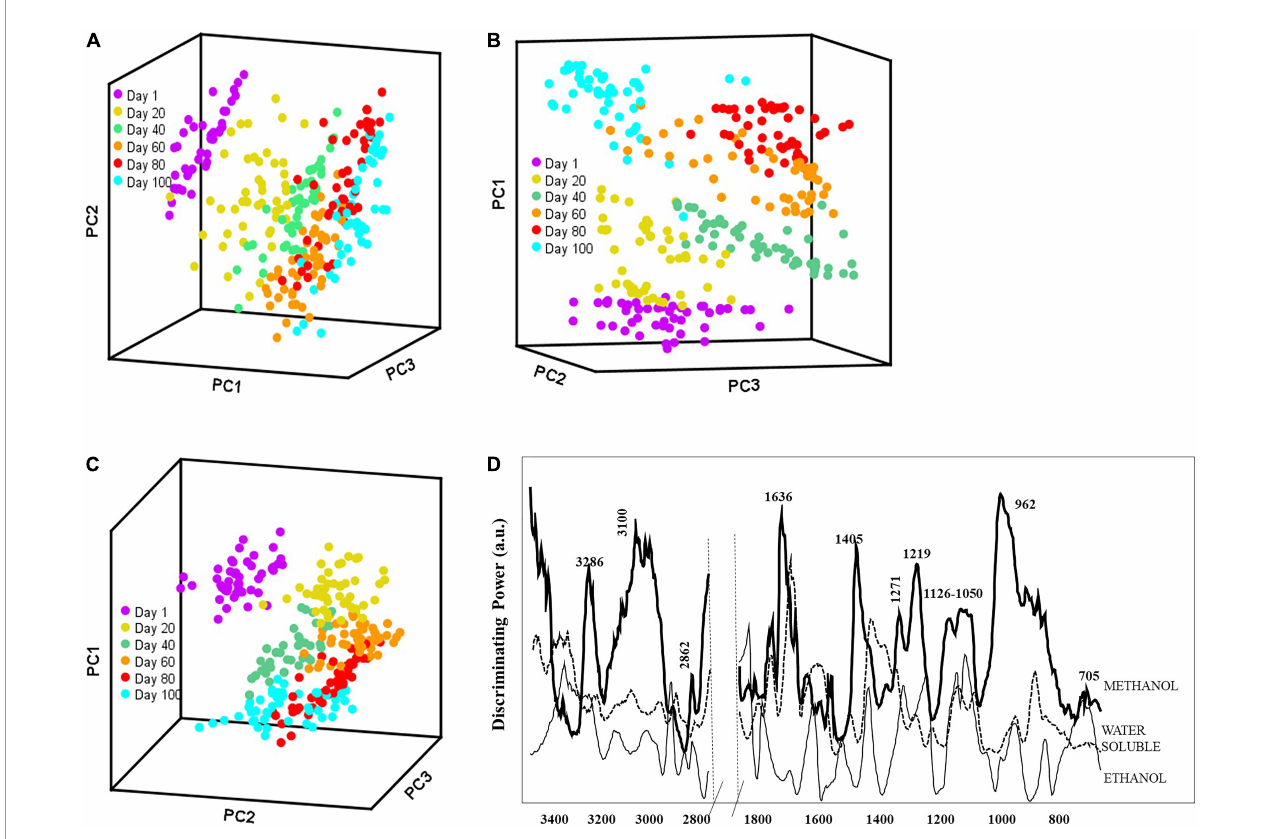
FIGURE2 Soft independent modeling of class analogy (SIMCA) 3D projection plots for spectra collected by portable FT-IR spectrometer for soluble extracts (A) water; (B) methanol; and (C) ethanol for 100 days ripening period and (D) SIMCA discriminating plot showing the bands and regions responsible for class separation based on the corresponding FT-IR SIMCA